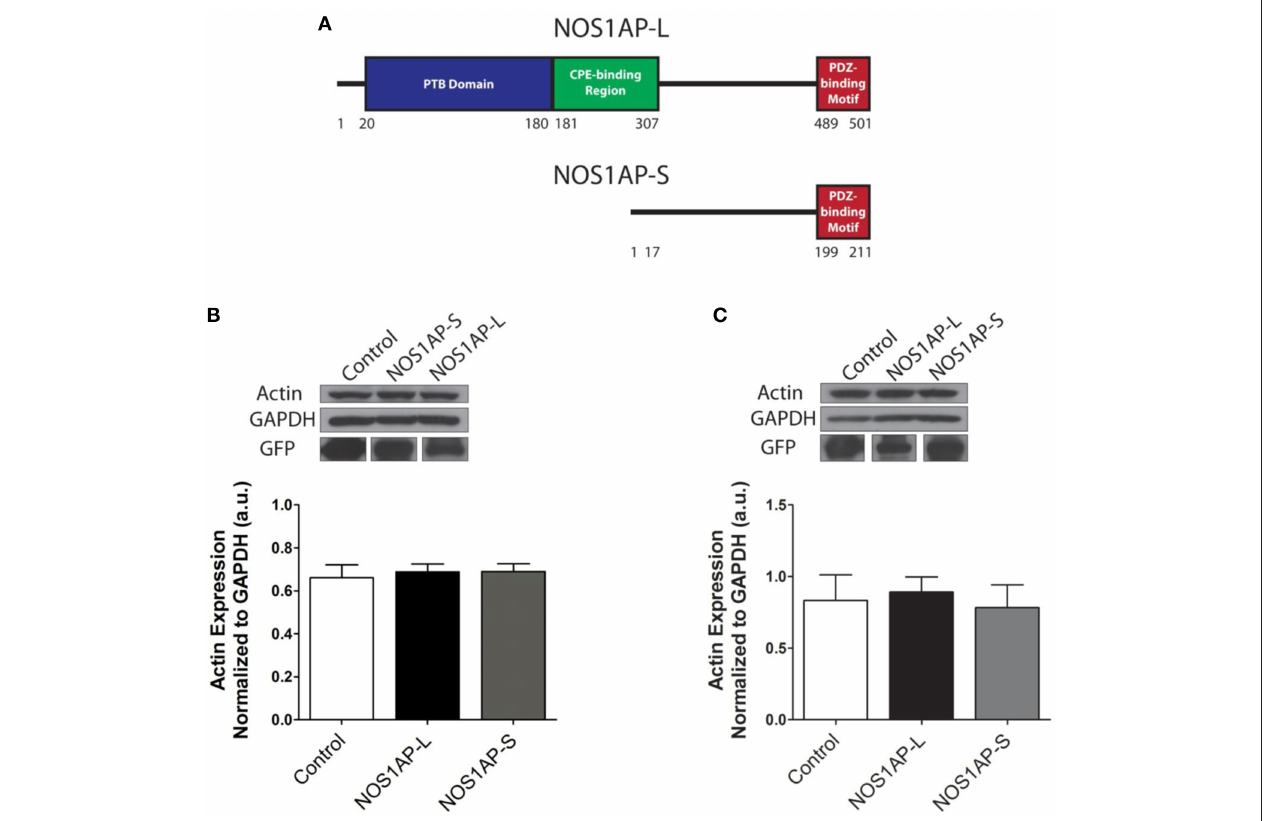
FIGURE 1 | Expression of NOS1AP-L or NOS1AP-S in COS-7 cells decreases F-actin. (A) Schematic of NOS1AP-Long and NOS1AP-Short protein domains. The long isoform of NOS1AP produces a protein with a PTB domain, CPE-binding region, and a PDZ-binding motif (NOS1AP-L). The short isoform of NOS1AP produces a protein with only the PDZ-binding motif (NOS1AP-S). The first 17 amino acids of NOS1AP-S are not present in NOS1AP-L. (B) Upper , extracts from cultures of transfected COS-7 cells expressing GFP (control), NOS1AP-L, or NOS1AP-S were resolved by SDS-PAGE and analyzed by Western blotting using antibodies that recognize actin or GAPDH. Representative blot is shown. Lower , densitometry analysis of multiple blots represented in upper . Error bars indicate ± s.e.m. n = 6 for all conditions. a.u., arbitrary units. (C) Upper , extracts from cultures of transfected HEK293T cells expressing GFP (control), NOS1AP-L, or NOS1AP-S were resolved by SDS-PAGE and analyzed by Western blotting using antibodies that recognize actin or GAPDH. Representative blot is shown. Lower , densitometry analysis of multiple blots represented in upper . Error bars indicate ± s.e.m. n = 5 for all conditions. a.u., arbitrary